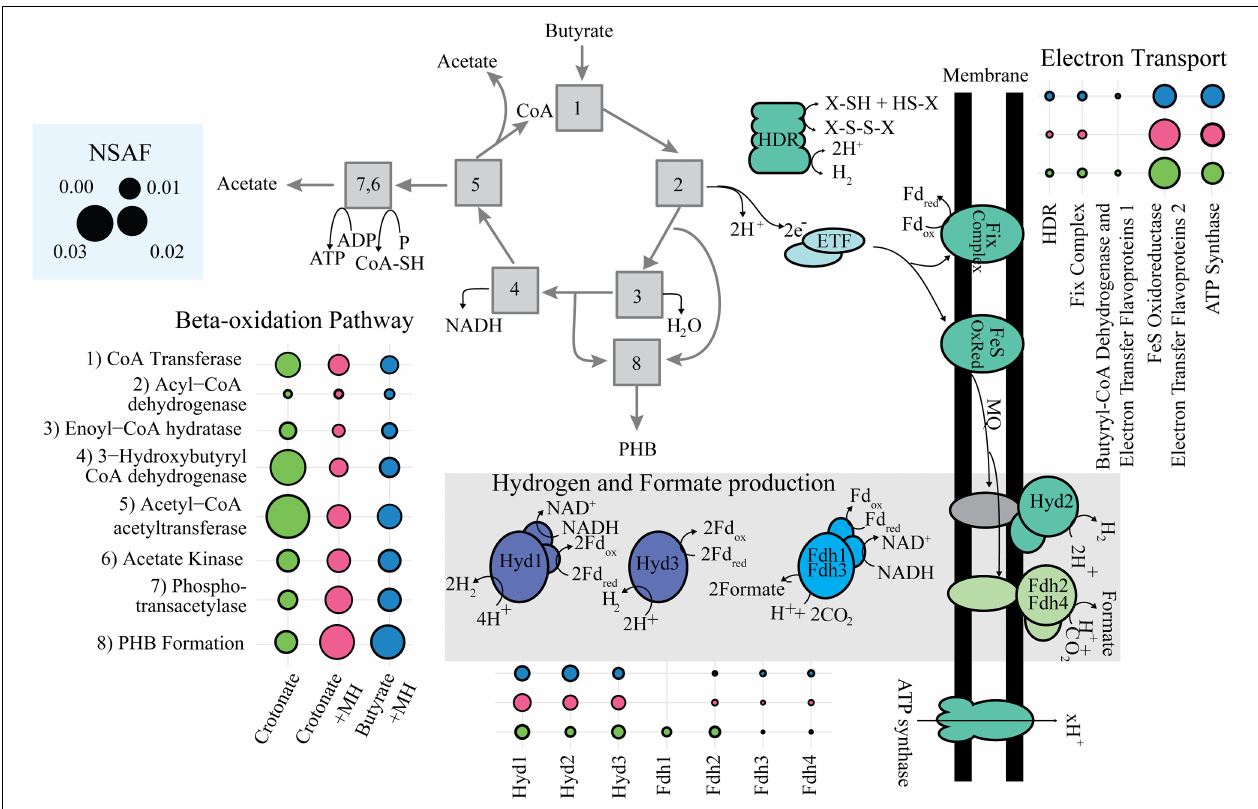
FIGURE 3 | Abundance of key enzymes of S. wolfei ’s metabolism. Abundance represented in the sum of NSAF for enzymes in each category. Symbols: green circle, S. wolfei pure culture on crotonate; pink circles, S. wolfei-M. hungatei coculture on crotonate; blue circles, S. wolfei-M. hungatei coculture on butyrate.